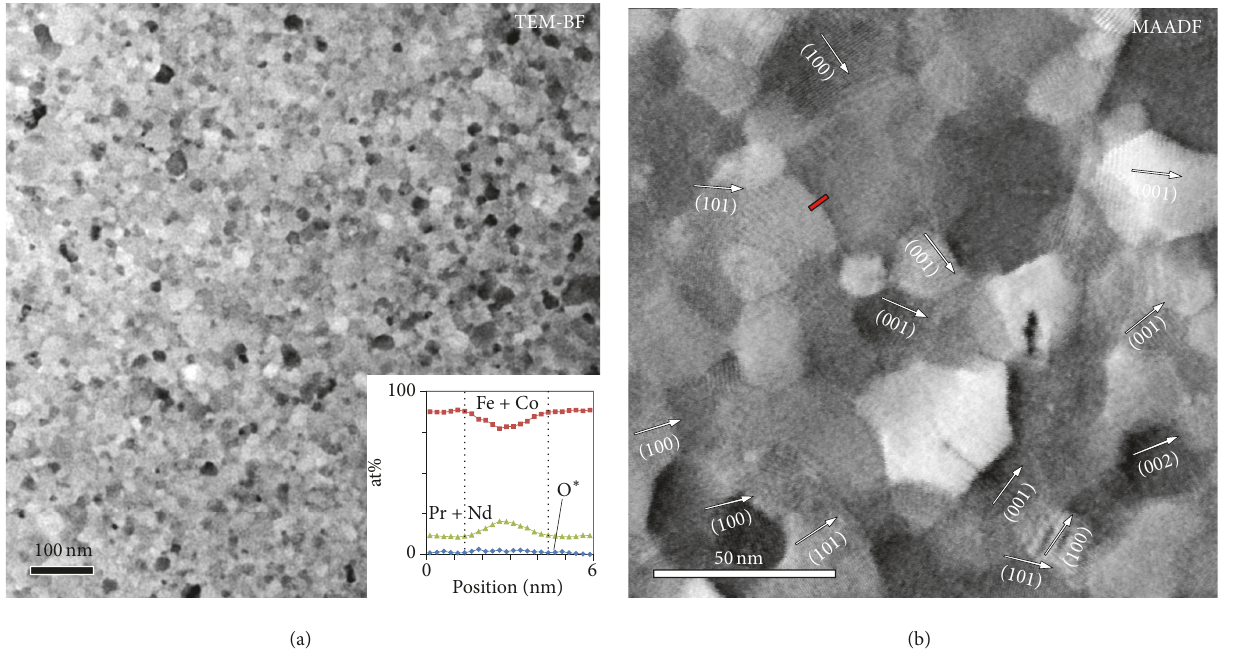
Figure 9: (a) TEM bright field (BF) image of small grained MQP-B+ magnet, [(a) insert] EELS line scan across a 3nm thick “Pr + Nd” enriched GB-phase, and (b) MAADF (cl = 970 mm) image with an isotropic distribution of the (001) lattice plane normal of the 2-14-1 grains and the EELS scan of Figure 9(a) (red line).